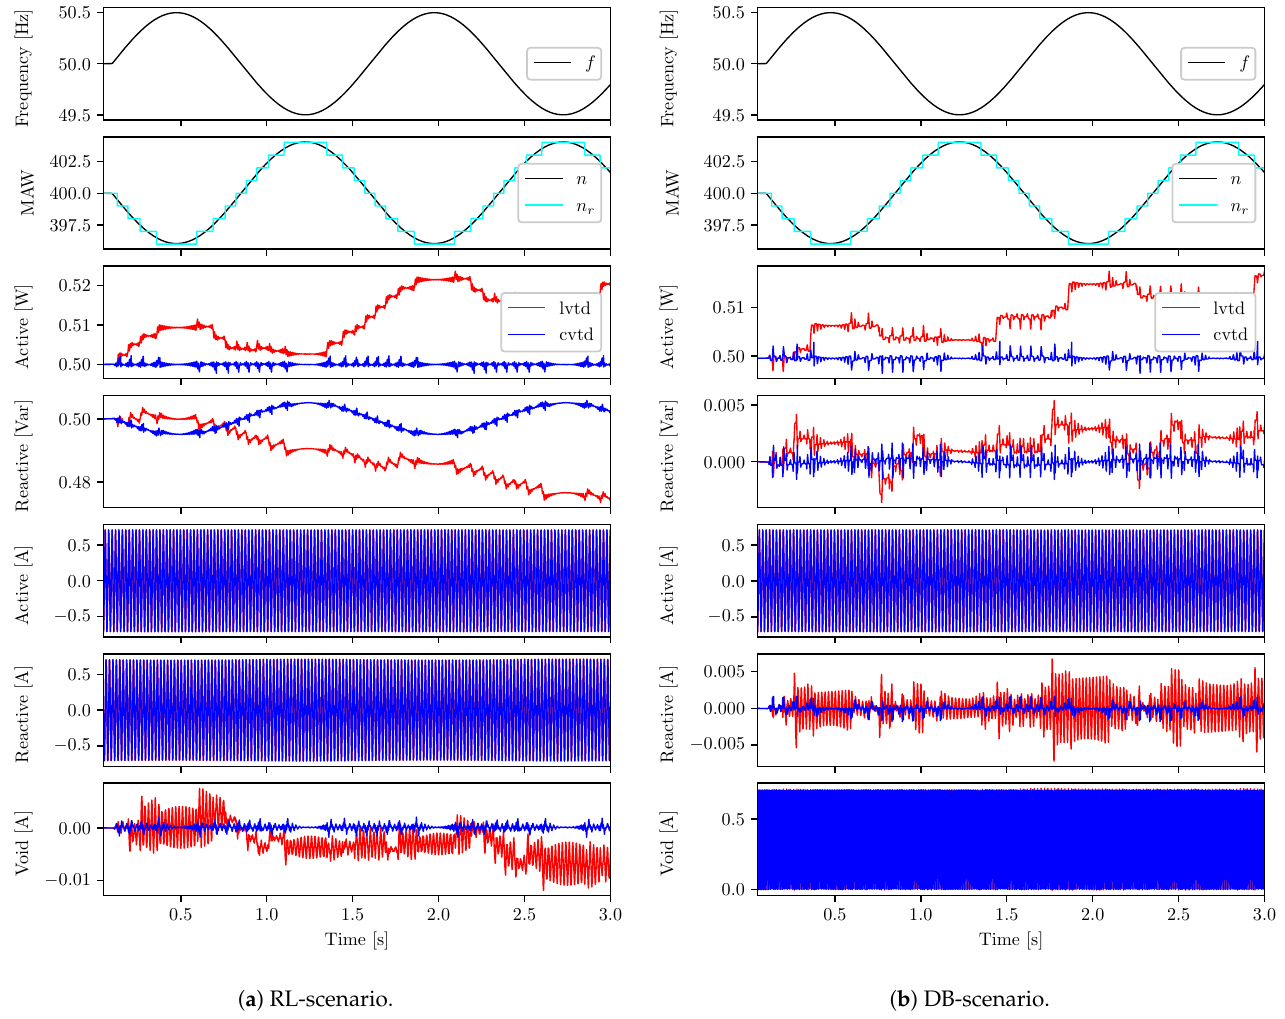
Figure 8. Continuous variation of the source frequency. LVTD in red versus CVTD in blue. Frequency and MAW : a sinusoidal disturbance with amplitude of 0.5 Hz and fre- quency 2/3 Hz is summed to the rated value of the source frequency at instant t = 0.1 s. The ideal value of the MAW n is shown in black. It goes down when the frequency increases and up when the frequency decreases. The rounded value of the MAW n r is shown in cyan. Active power : should be constant at 0.5 W irrespective of the frequency